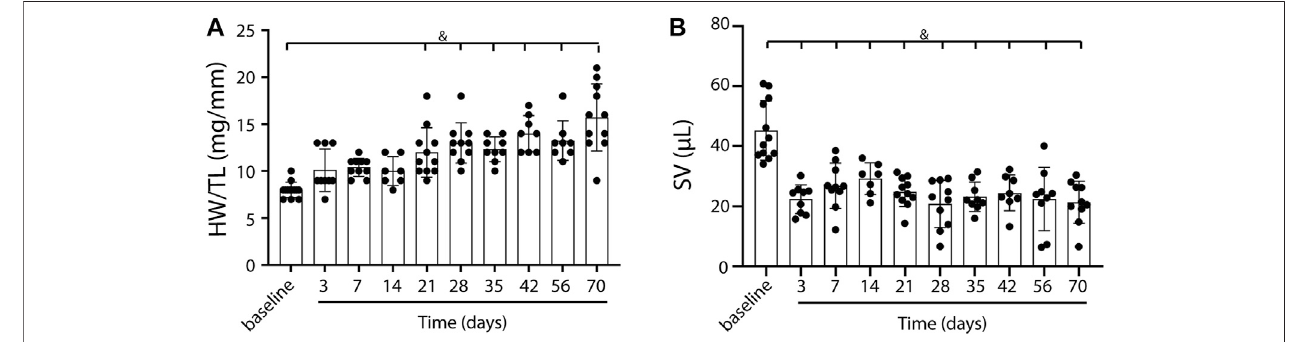
FIGURE 1 | Cardiac weight and function in TAC mice over time. A gradual increase in heart weight to tibia length ratio over time, indicating the presence of cardiac remodeling post-TAC (A) . Stroke volume decreases over time post TAC vs. baseline (B) . Mean ± SD. & (cid:1) p < 0.0001. HW/TL; Heart weight/Tibia length.